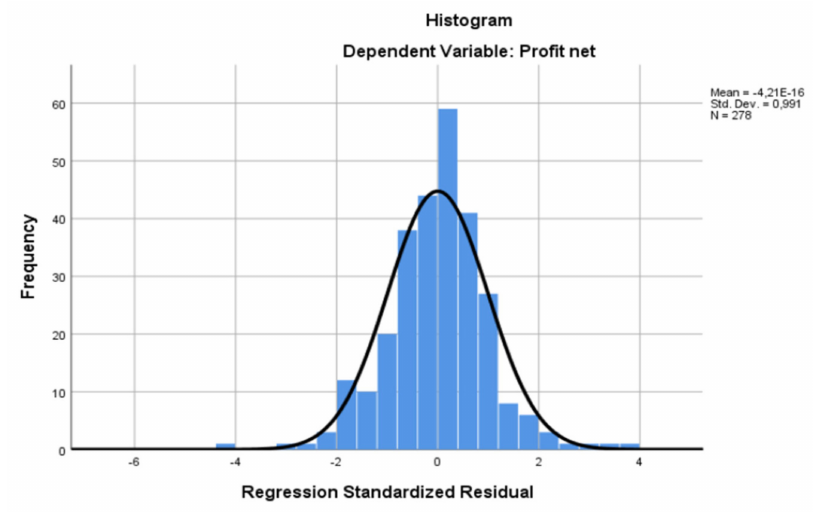
Figure 1. Graph of normality for error